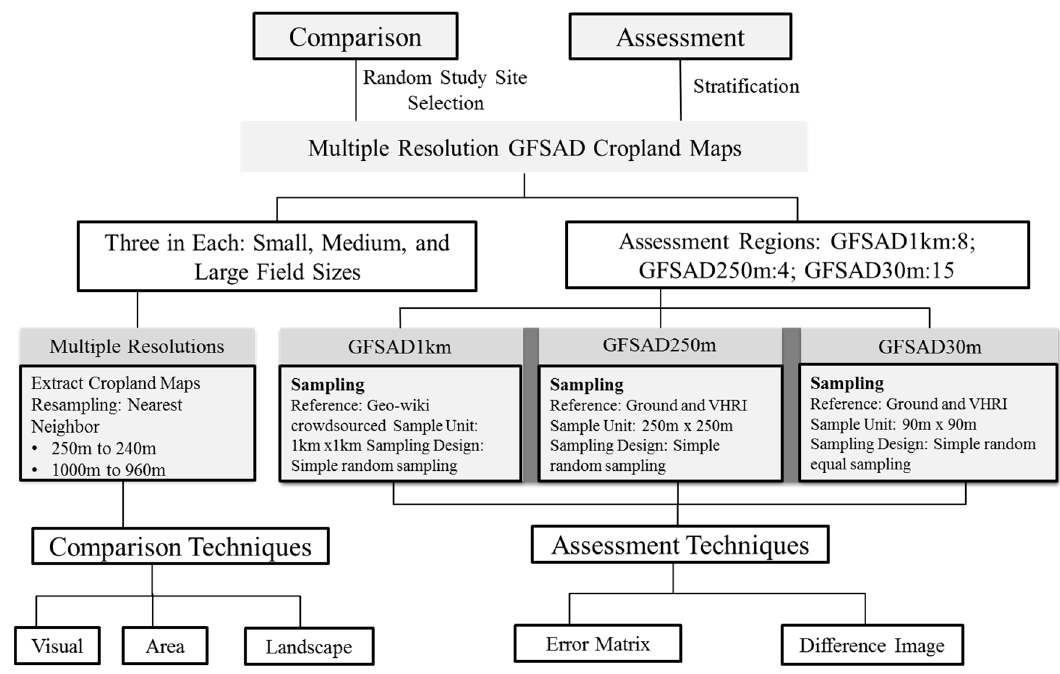
Figure 3. The overall flowchart showing the methods step followed to assess and compare different resolution GFSAD cropland extent